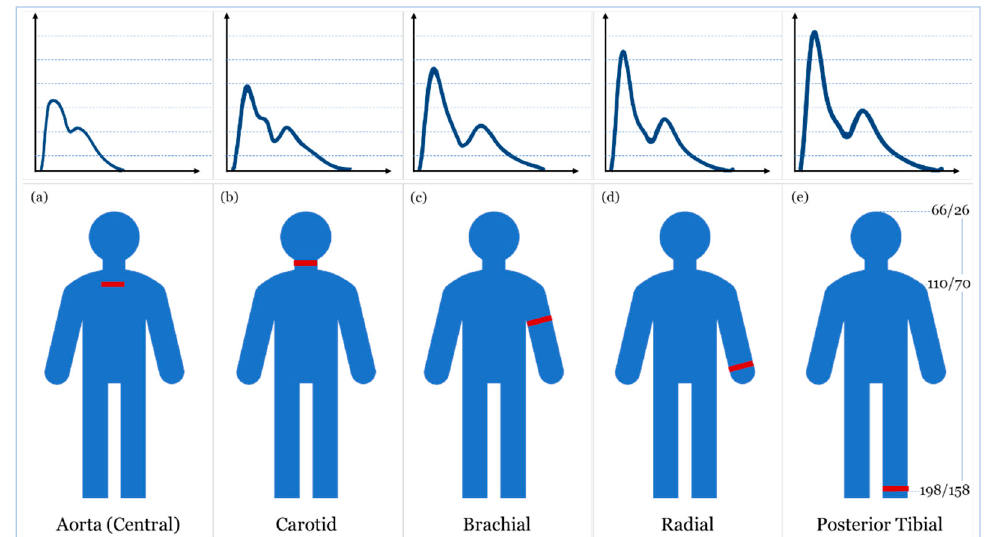
Figure 3. Schematic diagrams ( a – e ) illustrate the impact of artery stiffness and location on a blood pressure wave traveling through different arteries in an upright position. ( e ) shows blood pressure measurements in (mmHg) at three different locations (i.e., levels) in a person who is 182 cm tall: top of the head, heart, and foot.